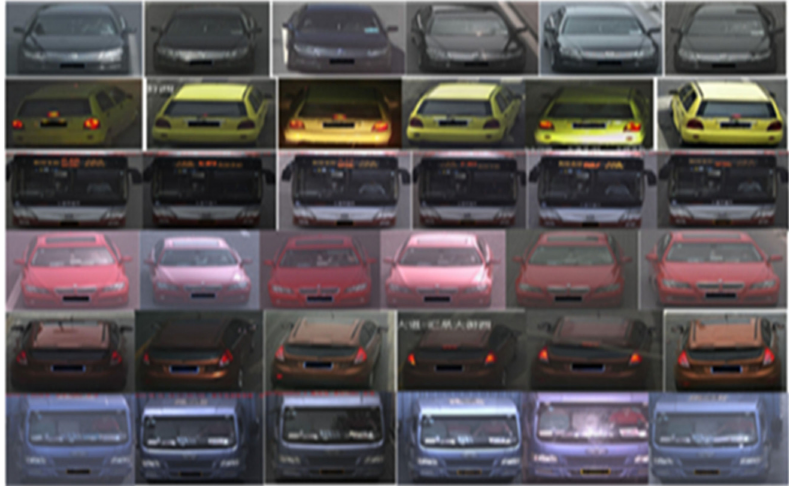
Figure 20. Depicts the sample images of PKU VehicleID dataset.